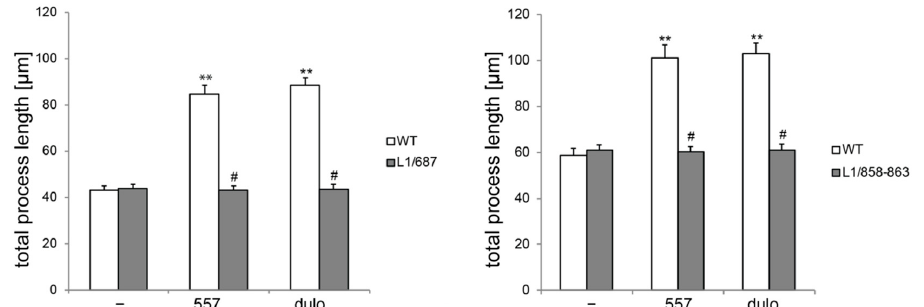
Figure 2. Schwann cells from L1/858–868 and L1/687 mice were not stimulated by antibody 557 or duloxetine. Schwann cells were prepared from 6- to 7-day-old male wild-type (WT, white bars) and L1 mutant littermate (gray bars) mice and seeded on a PLL substrate. Process lengths were determined after treatment without ( − ) or with 50 µg/mL of antibody 557 (557) or 100 nM of duloxetine (dulo) for 24 h. Values were obtained from three independent experiments analyzing 100 cells per genotype and condition for each experiment. Values show the means ± SD. ** p < 0.01 difference relative to PLL, # p < 0.05 difference relative to the wild-type (two-way ANOVA with Tukey´s post-hoc test).